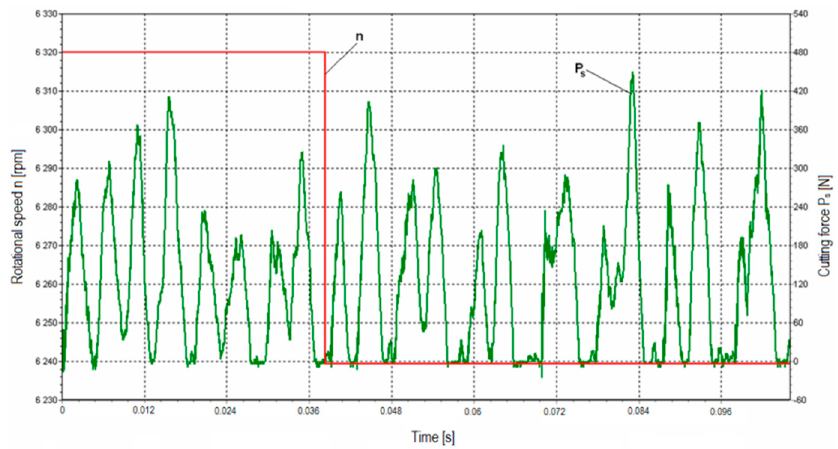
Figure 8. Cutting force variability at a feed force of 118 N.